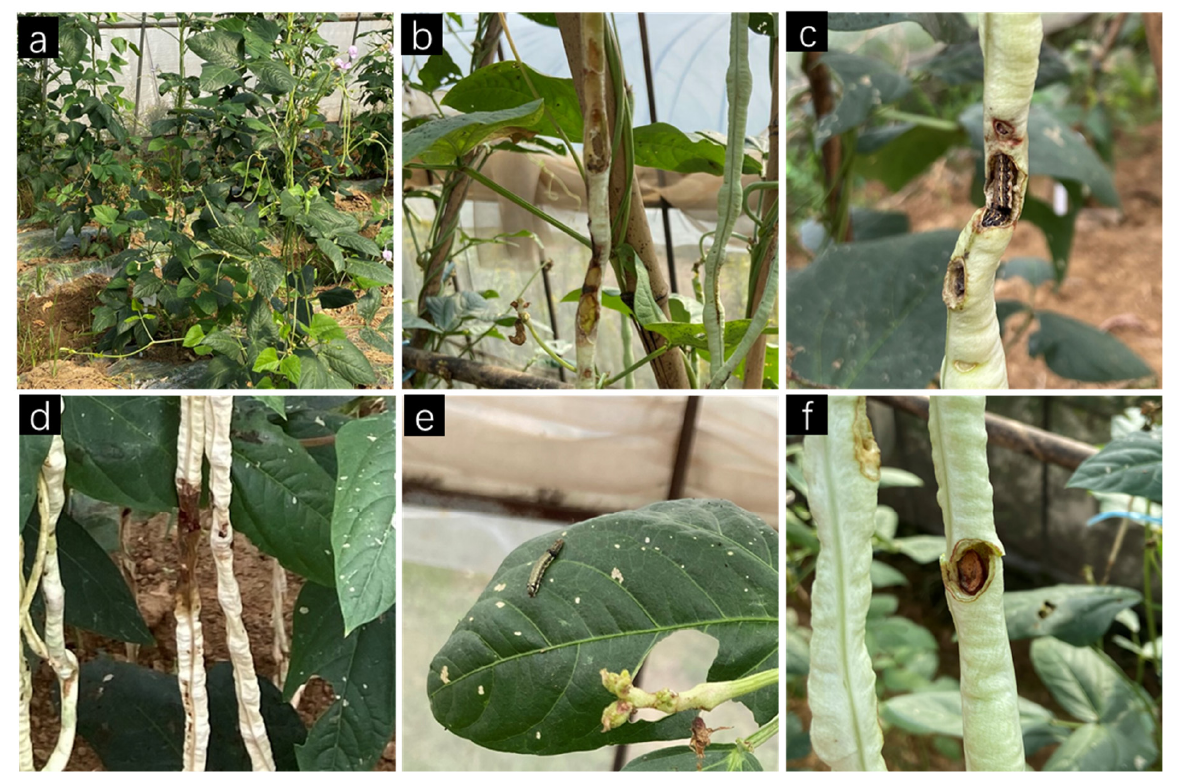
Figure 1. The damage of yardlong bean caused by the common cutworm. ( a ) Growth of the yardlong bean in a greenhouse; ( b ) The pod is nicked by the common cutworm; ( c ) The pod is perforated by the common cutworm which hid in the pod; ( d ) The pod is necrotic after the common cutworm feeds; ( e ) Common cutworm on the leaflet; ( f ) The pod and the seed are injured by the common cutworm.